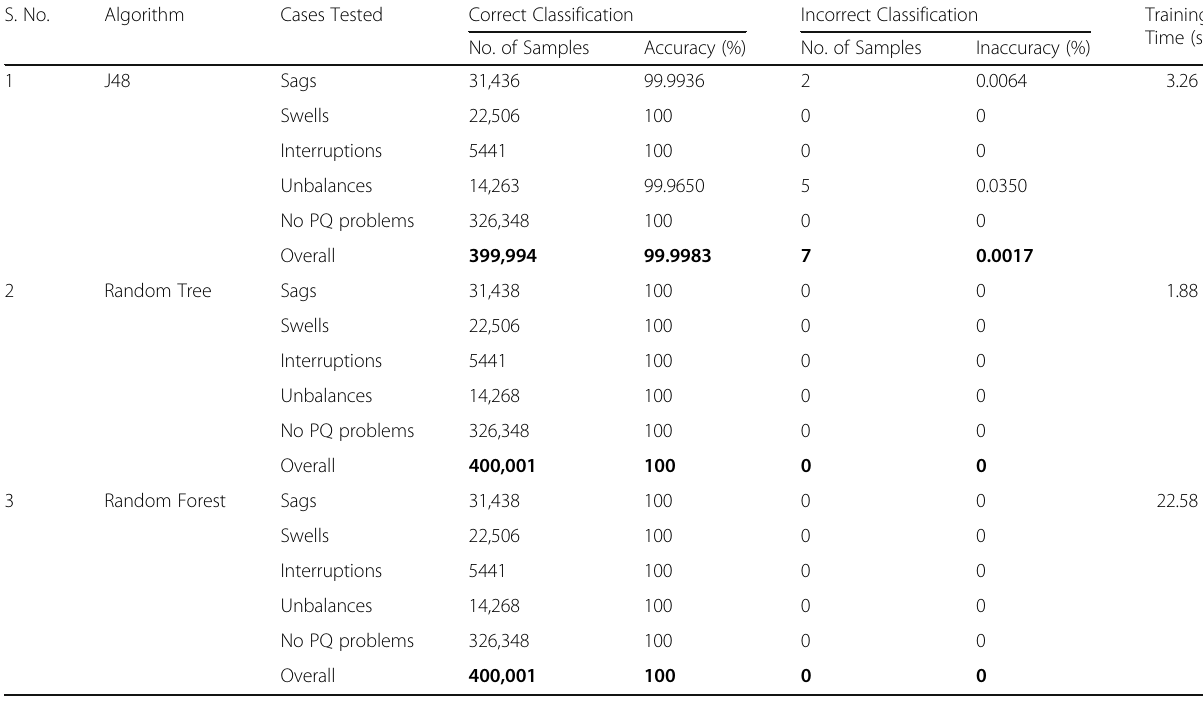
Table 4 Comparison of Data Mining Algorithms with 7 attributes for evaluation on training set S. No.